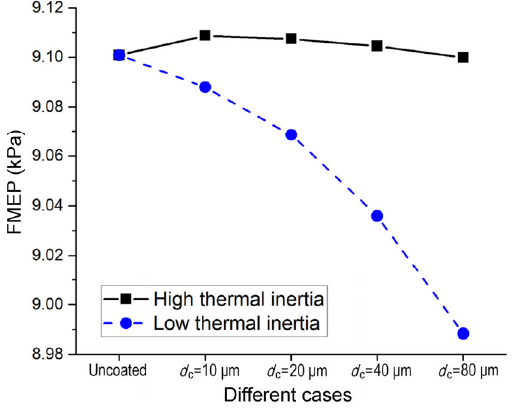
Fig. 9 The effect of coating thickness ( d c ) on FMEP results for the untextured conjunction with the high or low thermal inertia